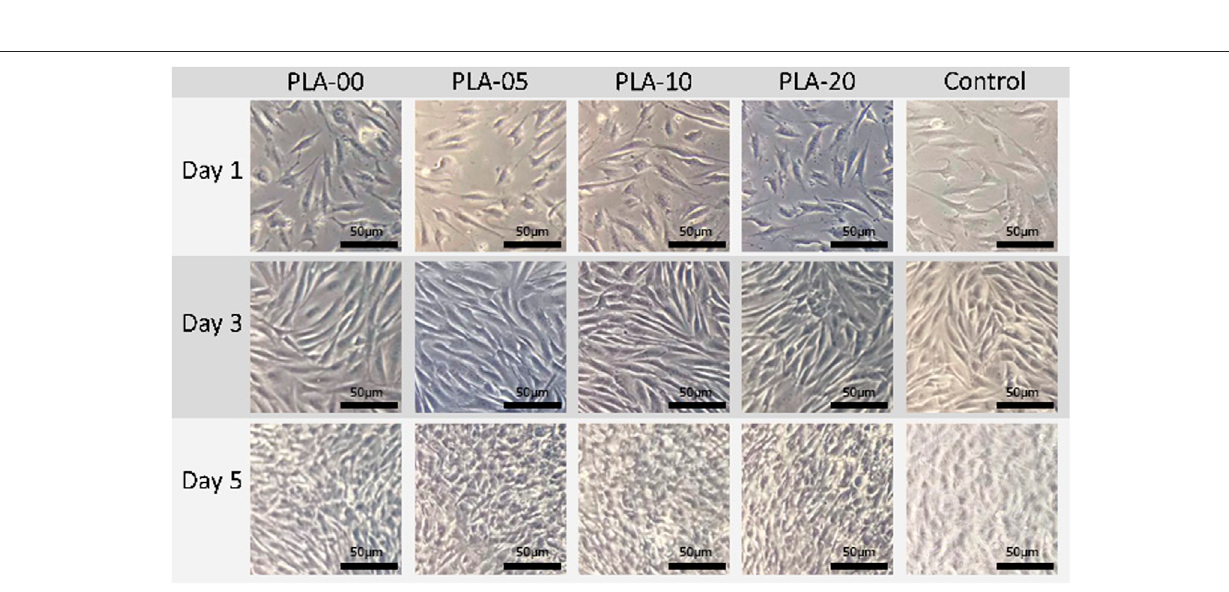
FIGURE 5 | Proliferative changes of osteoblast-like cells cultured on PLA/ β -TCP fi laments. Images were captured at 10 × magni fi cation. All bars (cid:2) 50 µm.